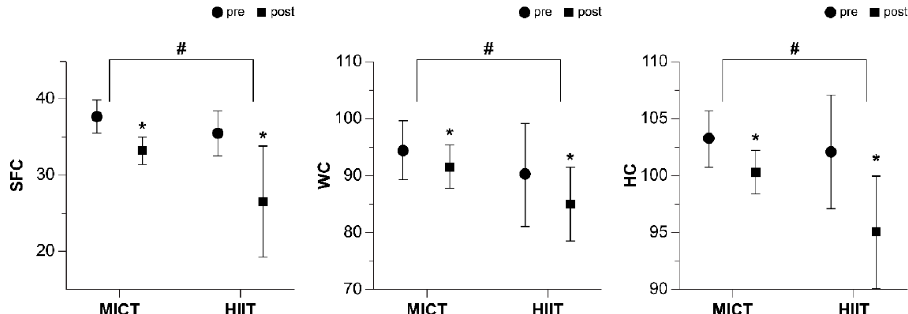
Figure 1. Effect on abdominal fat according to exercise intensity. HIIT: high-intensity interval training, MICT: moderate intensity continuous training, SFC: skin fold caliper, WC: waist circumference, HC: hip circumference. Bars represent mean ± SD (MICT: n = 8, HIIT: n = 8). * p < 0.05 from Pre to Post. # p < 0.05 change (post-pre) between groups.